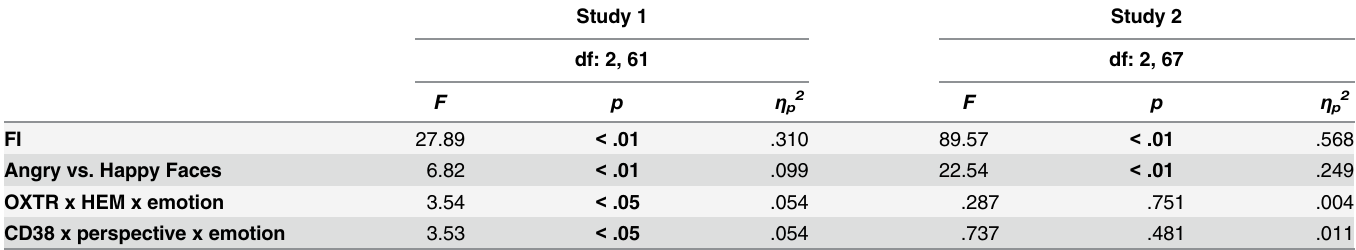
Table 9. Results of ANOVAs with repeated measurements regarding N170-latencies in reaction to upright and inverted happy and neutral faces (emotion); Hemisphere (HEM), perspective (upright vs. inverted picture), CD38-SNP rs379863 (CD38), Oxytocin-receptor-gene-polymorphism rs53576